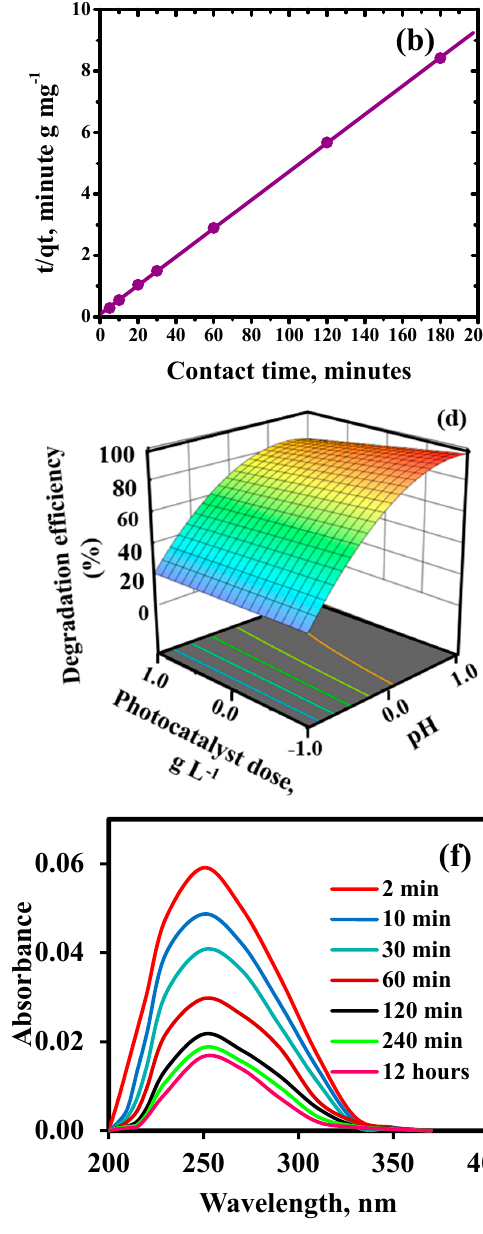
Figure 7. Removal efficiency of Pb(II) as a function of adsorbent dose and temperature ( a ), Pseudo–second order kinetic model ( b ), Langmuir adsorption isotherm ( c ), Degradation efficiency of